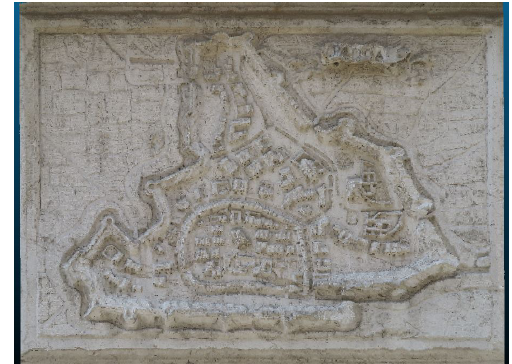
Figure 5. Frontal view of the 3D model of the low relief ob- tained by using the software under development at the University of Padova. Finally, Fig 6 shows the comparison (cloud to cloud distance computed with Cloud Compare) between the two point clouds generated with Agisoft PhotoScan and by our software. Values have been saturated to 0.02cm, approximately, whereas green and blue start at 0.011m and 0.0015m, approximately.